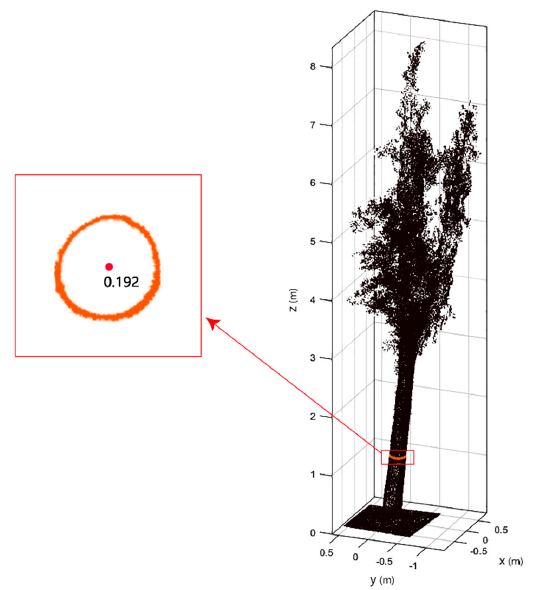
Figure 8. Single tree diameter extraction based on point cloud data. The orange position in the red box on the right is the breast height position and the red box on the left side is the point cloud of the intercepted breast height position while the DBH is automatically extracted. The unit is meter.